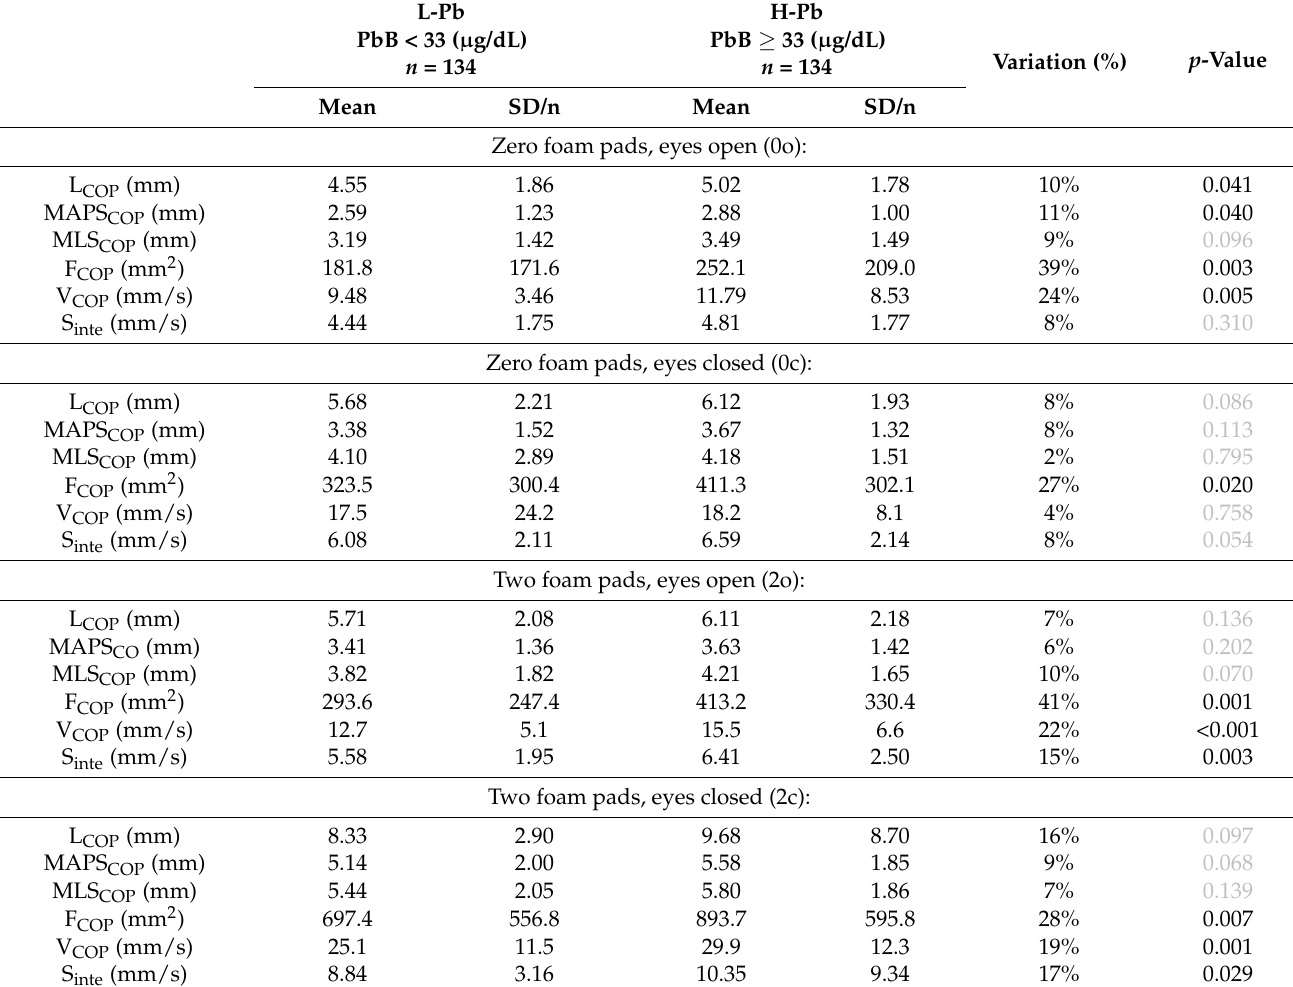
Table 3. Posturography test